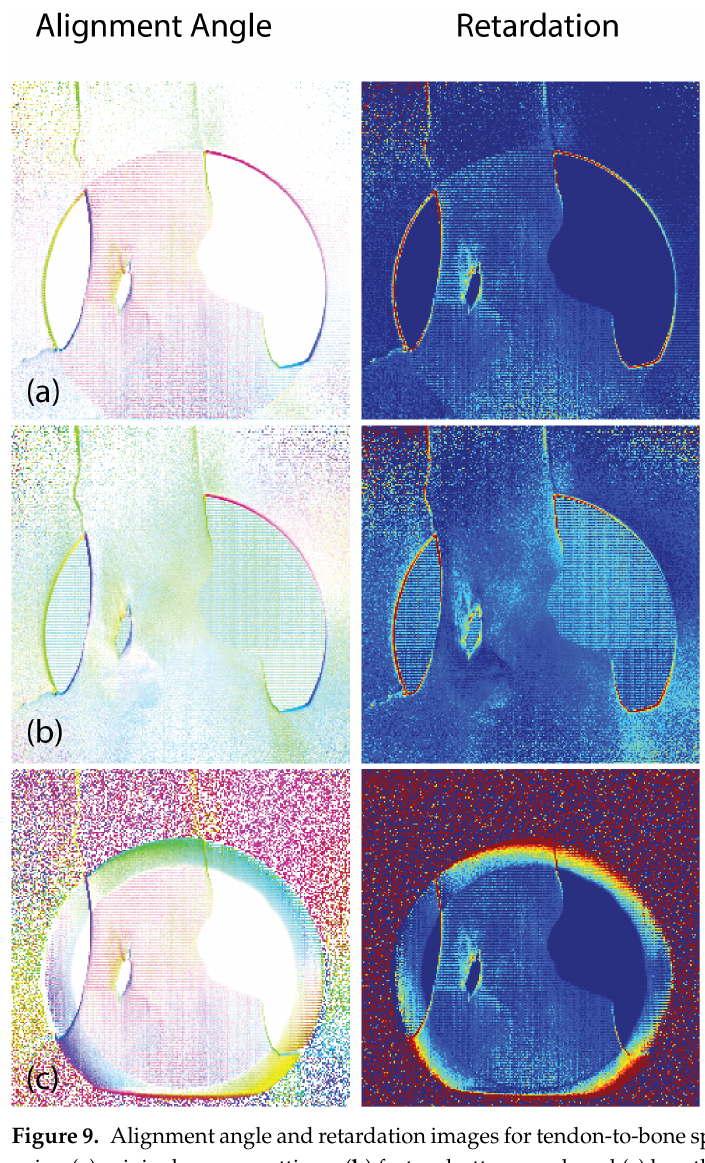
Figure 9. Alignment angle and retardation images for tendon-to-bone specimen 1 at 2.0 ms, calculated using ( a ) original camera settings; ( b ) faster shutter speed; and ( c ) breather sheet with original camera settings. Filtering was not applied to any of the